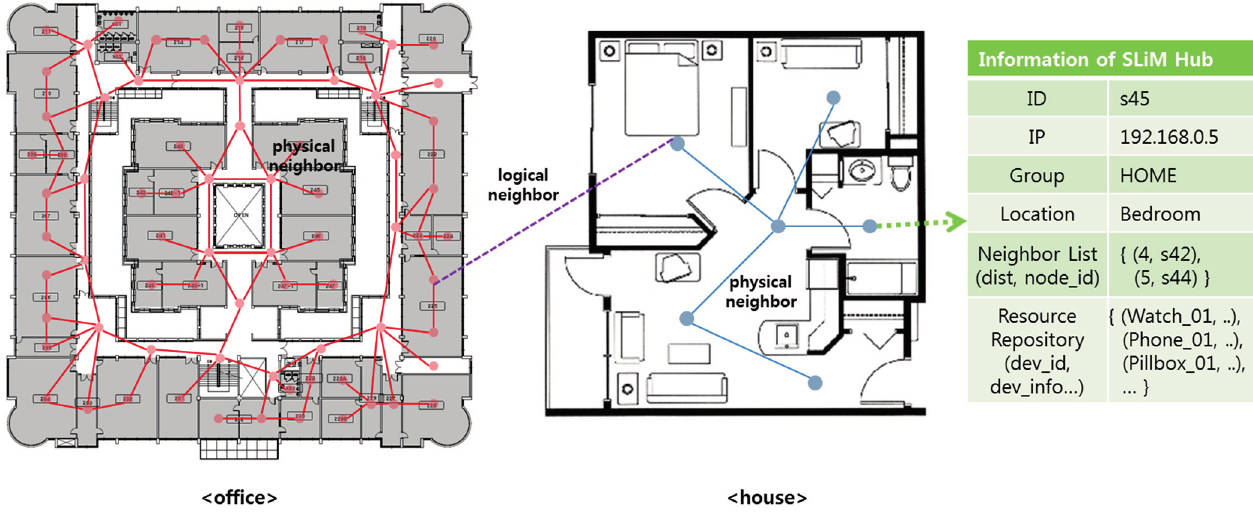
Figure 6. Physical and logical